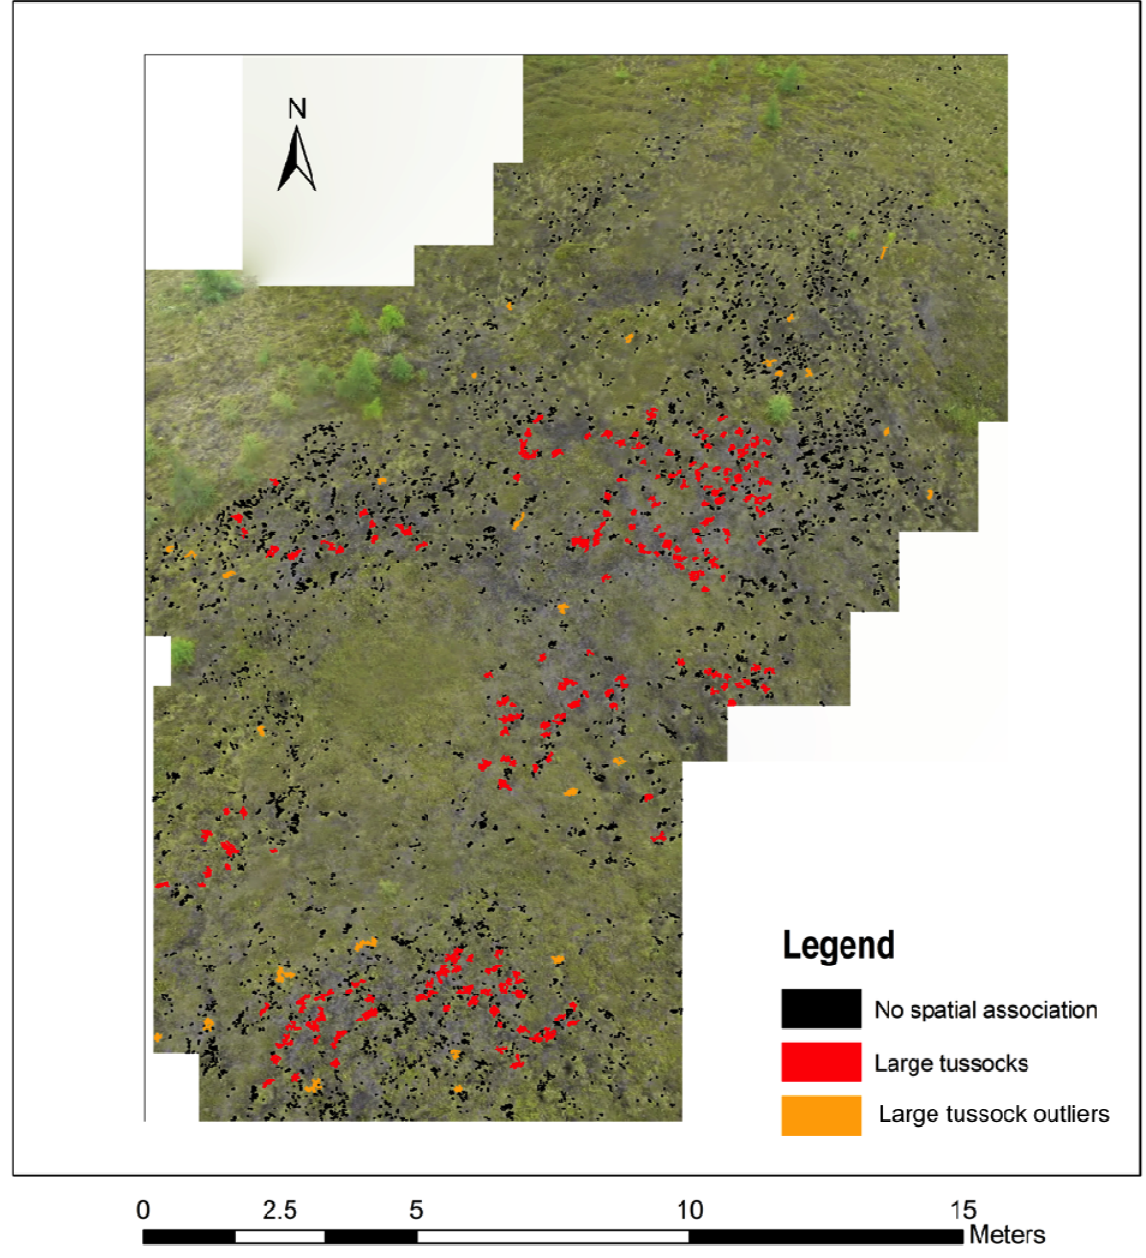
Figure 4. Example of a mosaic with the classified E . vaginatum tussocks overlain. Pixels in grey do not have any spatial association by tussock size. Pixels in red are clusters of “large” tussocks while yellow are outliers of large tussocks surrounded by small